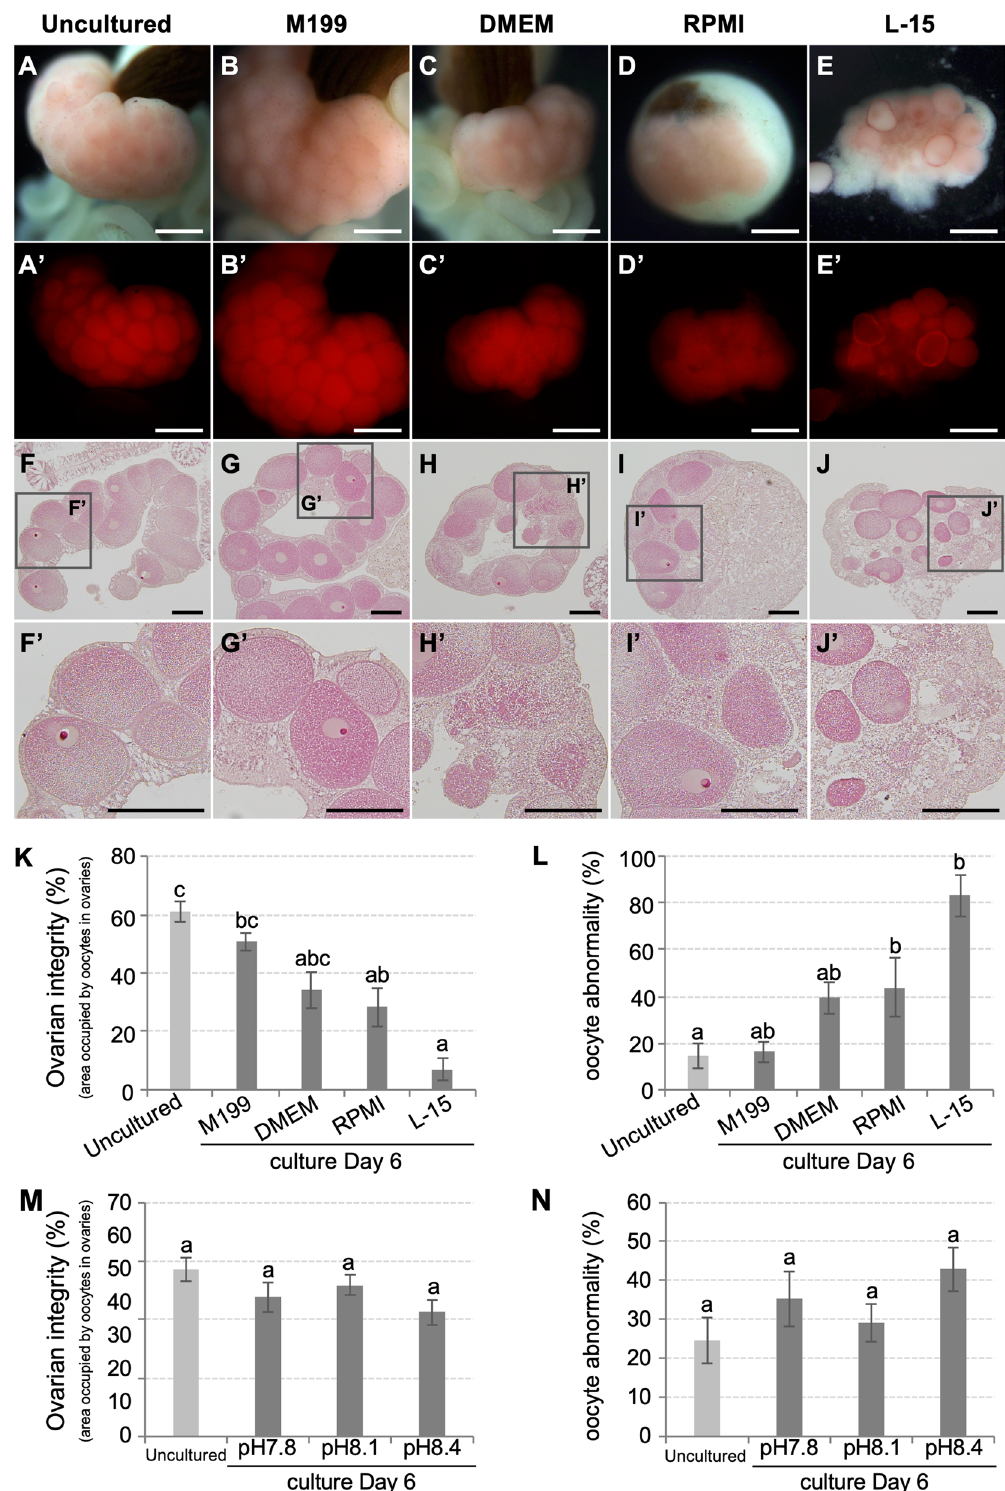
Figure 3. Effects of 4 commercially available culture media and medium pH. Brightfield views of freshly isolated mesenterial tissues ( A ) and mesenterial tissues cultured in M199 ( B ), DMEM ( C ), RPMI ( D ), or L-15 ( E ) for 6 days. ( A ′ – E ′ ) U-MWIG 2 (RFP) filter views of the same field as ( A – E ). HE sections of freshly isolated mesenterial tissue ( F ) and mesenterial tissues cultured in M199 ( G ), DMEM ( H ), RPMI ( I ), and L-15 ( J ) for 6 days. ( F ′ – J ′ ) Higher magnification views of the insets shown in ( F ′ – J ′ ). Effects of the 4 commercially available culture media ( K , L ) and medium pH ( M , N ) on ovarian integrity and oocyte status. Ovarian integrity was estimated by the ratio of the area occupied by oocytes in ovaries. Disappearance and abnormalities of oocytes in ovaries decrease this value. Oocyte status (oocyte abnormality) was examined histologically. Data are shown as means ± SE. Groups with different letters are significantly different (Kruskal–Wallis test, p < 0.05 and Dunn- Bonferroni post hoc test, p < 0.05). Scale bars = 500 μm ( A – E , A ′ – E ′ ); 200 μm ( F – J , F ′ – J ′